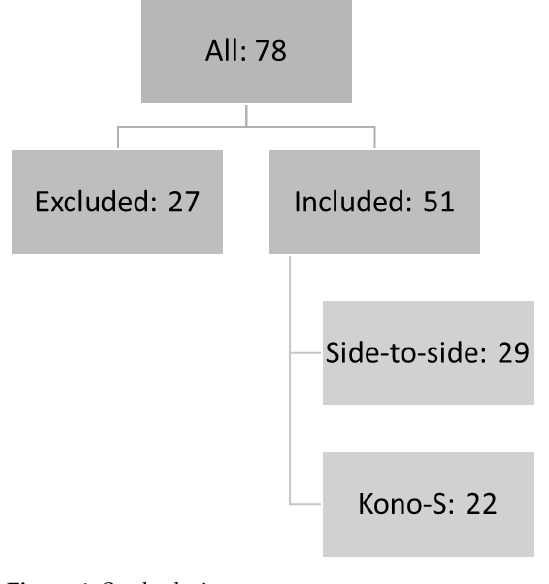
Figure 1. Study design. Figure 1. Study Table 1. Patient characteristics.